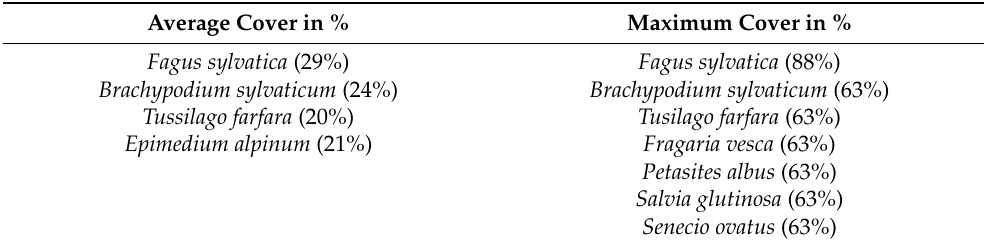
Table 5. Plant species with highest average (at least 20% or more) and maximum (more than 60%) cover at all sample plots of studied forest